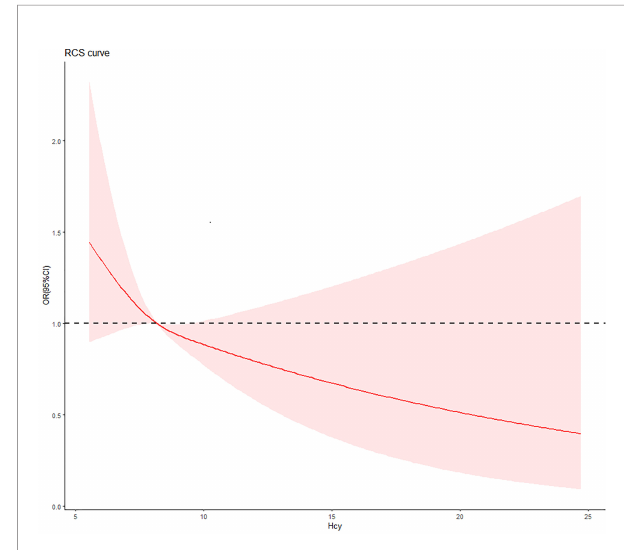
FIGURE 2 | The relationship between Hcy concentration and DR risk in T2D patients. The red curve was derived from multivariate analysis that adjusted